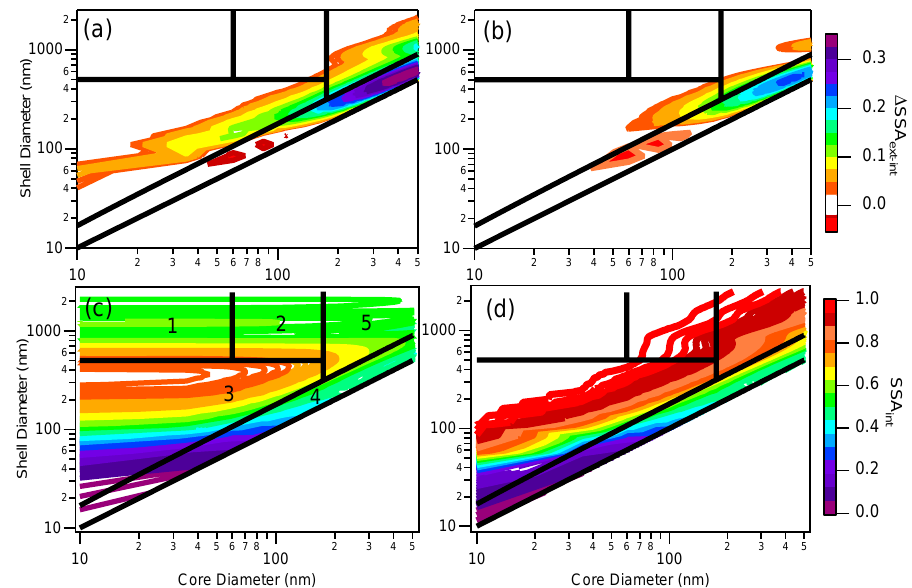
Fig. 7. Contour plots of the calculated difference in the SSA between an external mixture and an internal mixture for a coated BC particle with a C Clear coating (a) and a C Brown coating (b) are shown as a function of core and shell diameter. Contours are shown only when | 1 SSA | > 0.03. The color scale shown applies to both graphs. The actual SSA for the BC / C ext − int mixtures are shown for reference. Note that absorption by the C Brown shell narrows the size region over which large differences between the internal and external mixture are